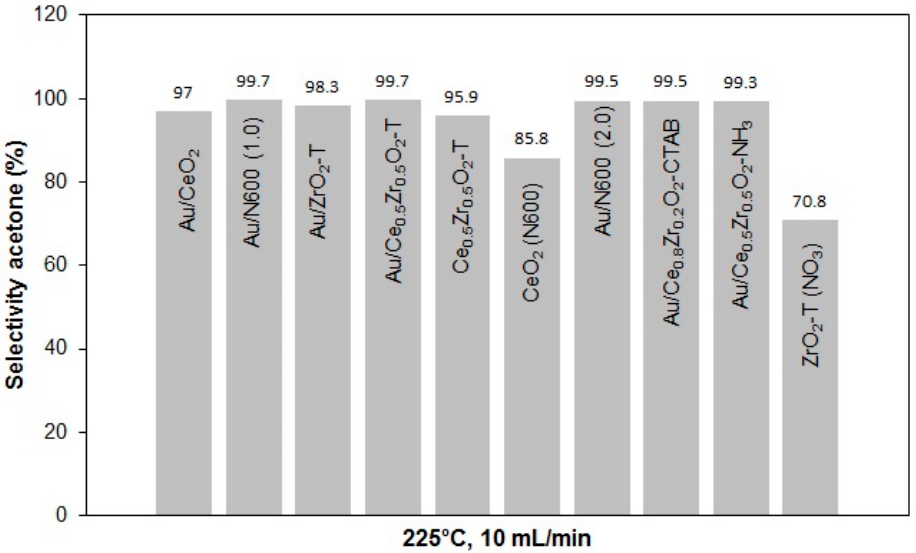
Figure 15. Acetone selectivities for various catalysts at 225 °C, 10 mL/min He through 2-propanol.